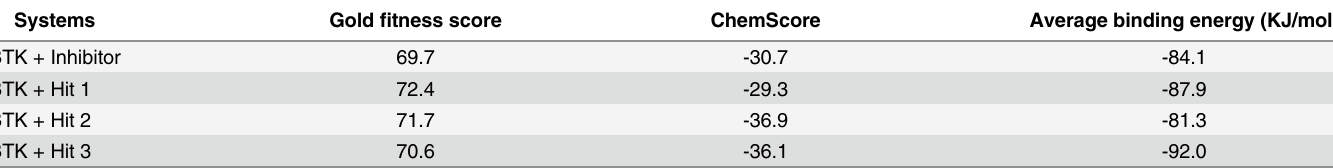
Table 4. Comparison of Gold fitness score, Chemscore and average binding energy of Btk and reference inhibitor/hit1/hit2/hit3